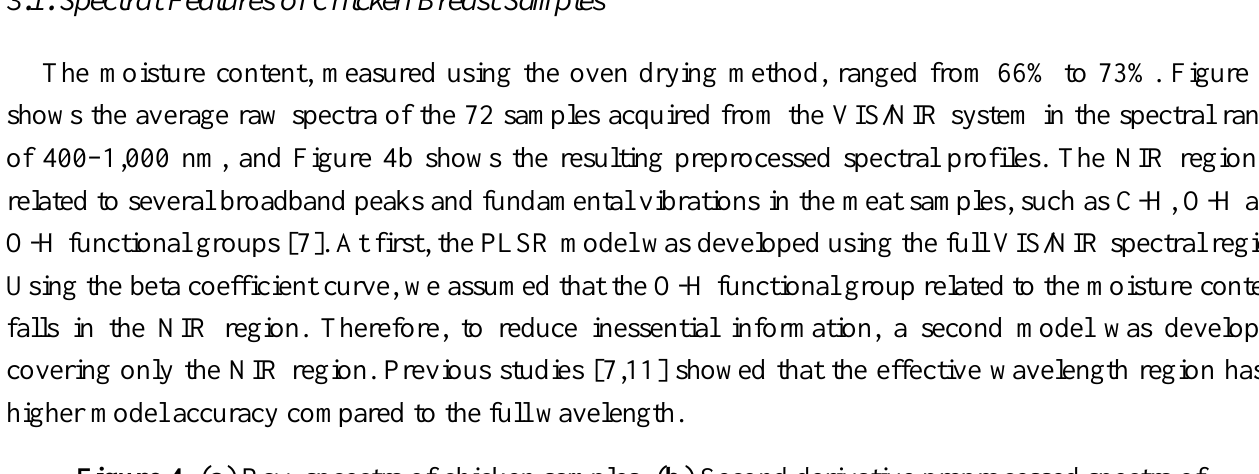
Figure 4. ( a ) Raw spcectra of chicken samples; ( b ) Second derivative preprocessed spectra of chicken